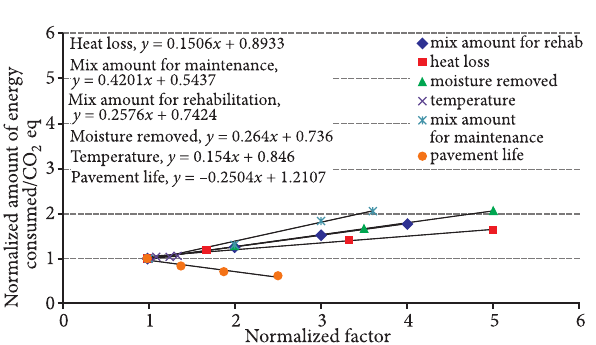
Fig. 8. Comparison of effects of